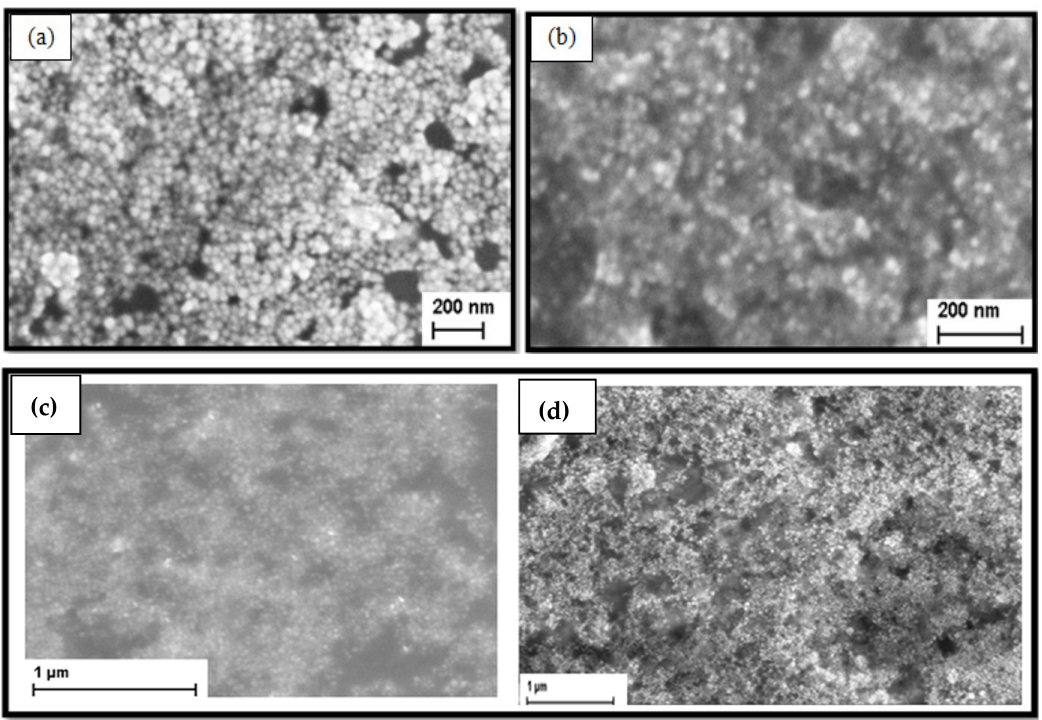
Figure 7. SEM images of AgNPs synthesized using A. indica and M. indica ; ( a ) A-AgNPs and ( b ) M-AgNPs at high magnification; and ( c ) A-AgNPs and ( d ) M-AgNPs at low magnification .